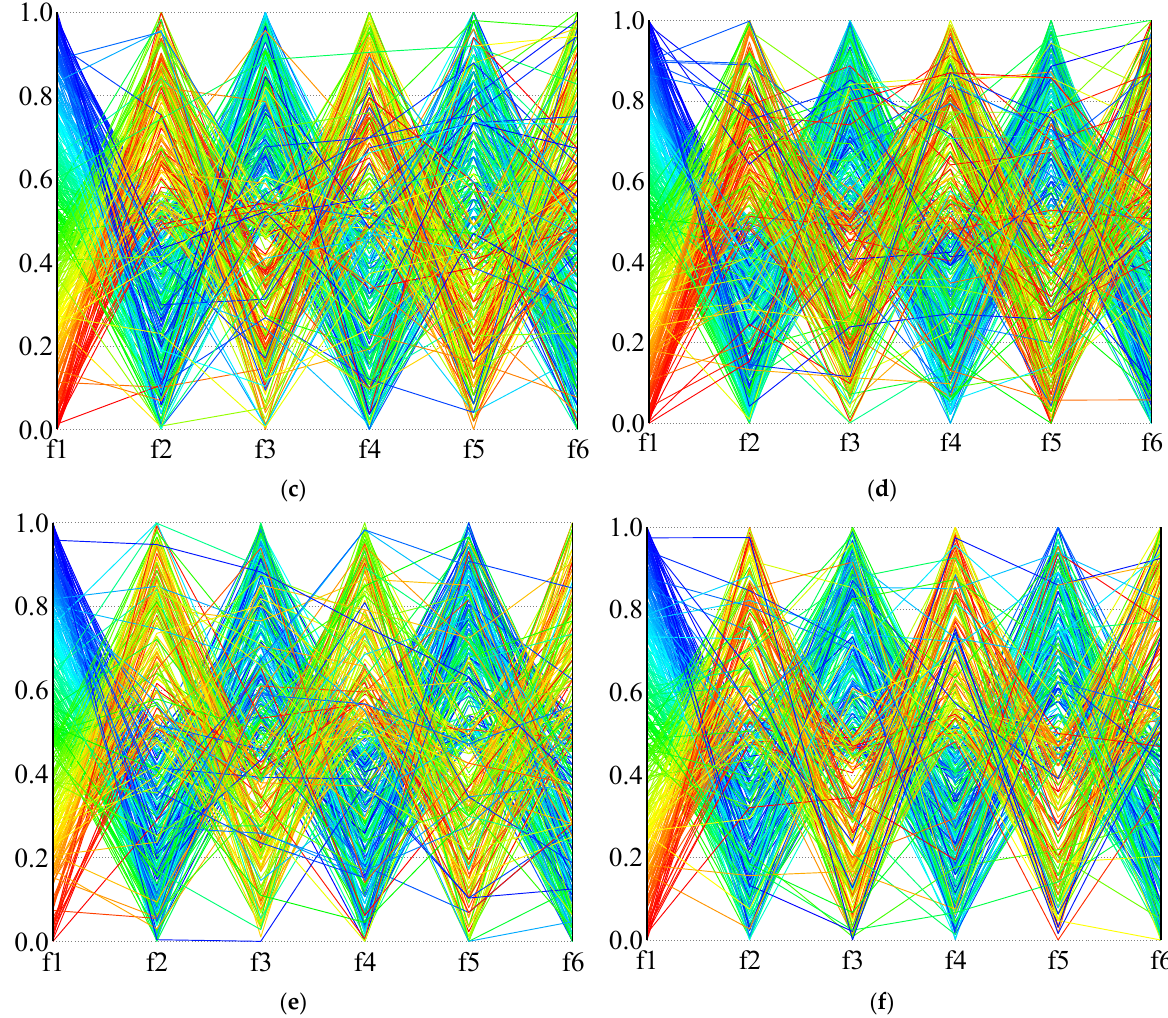
Figure 15. Parallel coordinates plot of instance 24B: ( a ) NSGA-III-L; ( b ) NSGA-III-NL; ( c ) NSGA-II-L; ( d ) NSGA-II-NL; ( e ) RWGA-L; ( f ) RWGA-NL.